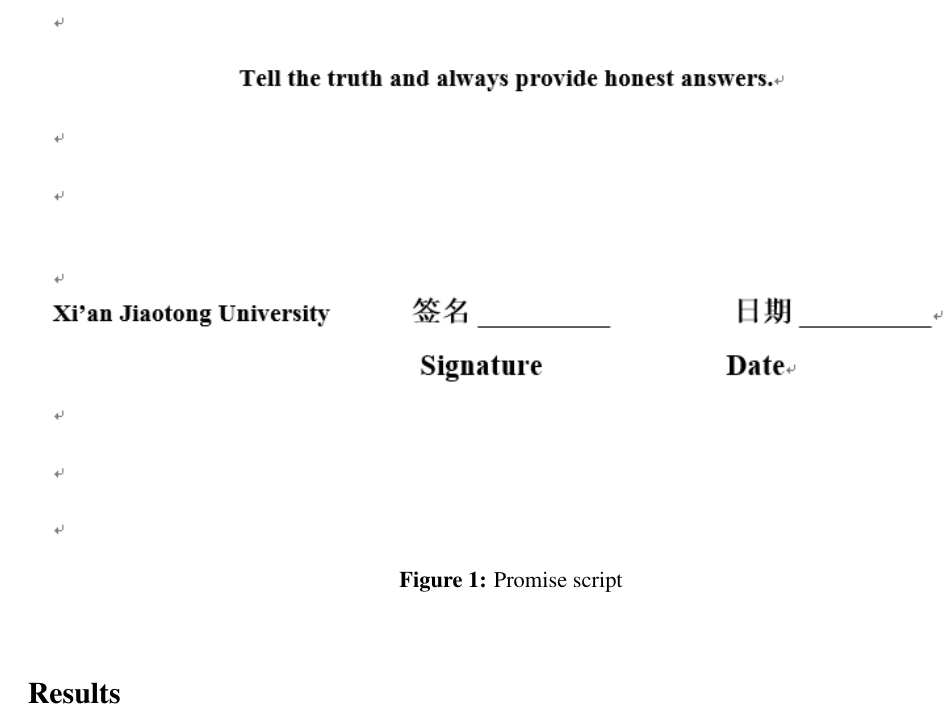
Figure 1: Promise